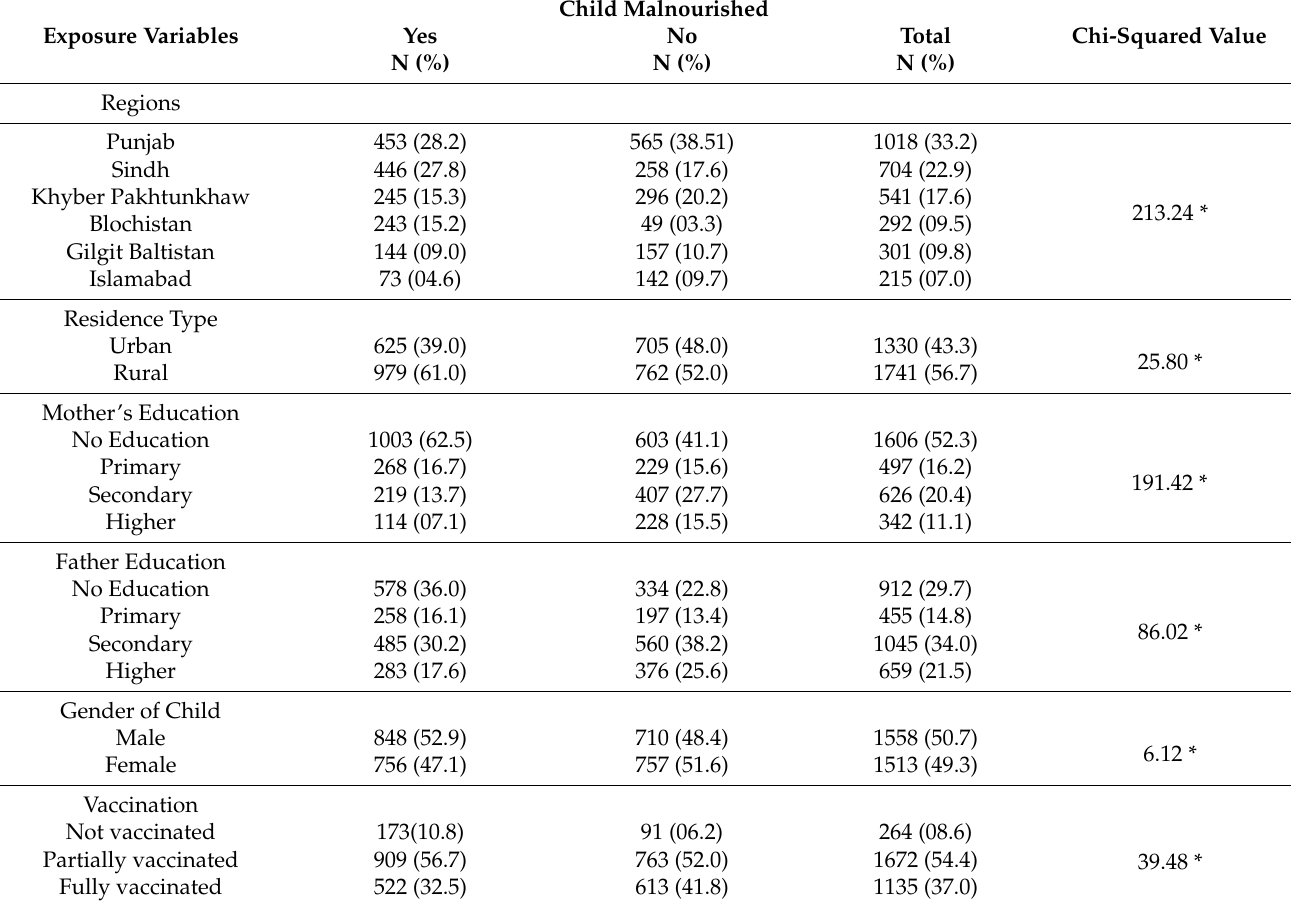
Figure 2. Type of Residence, Mother’s Education and Prevelance of Mulnutrition. Multiple Correspondence Analyses: A total of about 74% of the inertia is explained by the first two dimensions. Points of the different categories of the same variables are clearly separated (Figure 3). Stunting and wasting appeared in the second and fourth quadrants of the plot, indicating that they are not associated. Underweight lies on the borderline between the second and fourth quarter, indicating that it is associated with